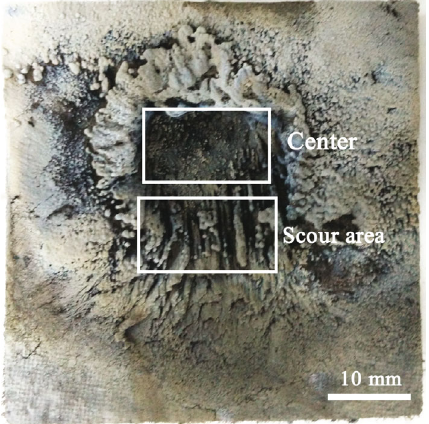
Figure 5: Ablation morphology of the specimen C2.